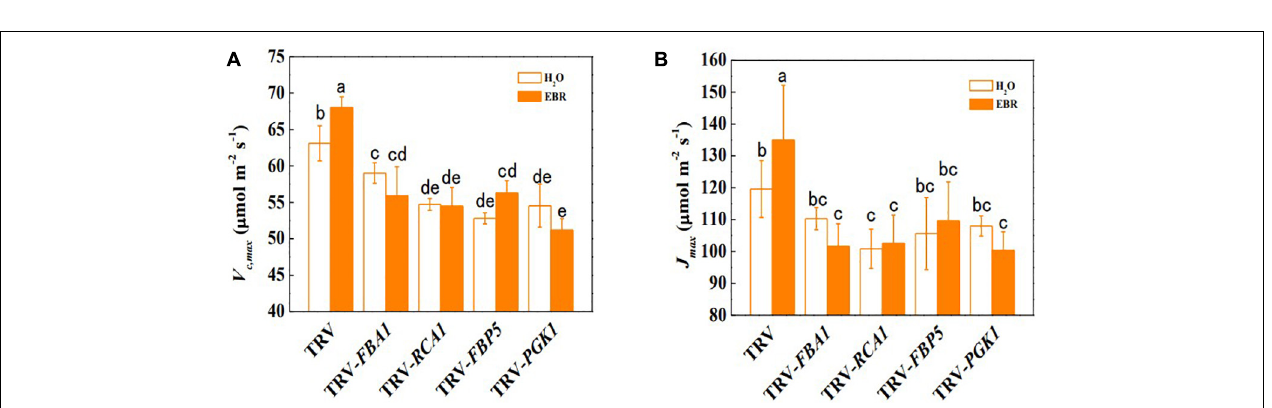
FIGURE 6 | FBA1, RCA1, FBP5, and PGK1 are important in the BR-induced Calvin cycle. (A) Maximum ribulose-1,5-bisphosphate carboxylase/oxygenase (RuBisco) carboxylation rate ( V c , max ). (B) Maximum ribulose-1,5-bisphosphate (RuBP) regeneration rate ( J max ). Five-week-old plants were used in this analysis. EBR (200 nM) was applied at 8:00 in the morning. For (A) and (B) , values were measured 48 h after EBR treatment. Data are the means ± SD of four biological replicates. Different letters represent significant differences ( p < 0.05) according to Tukey’s test. Three independent experiments were performed with similar results.